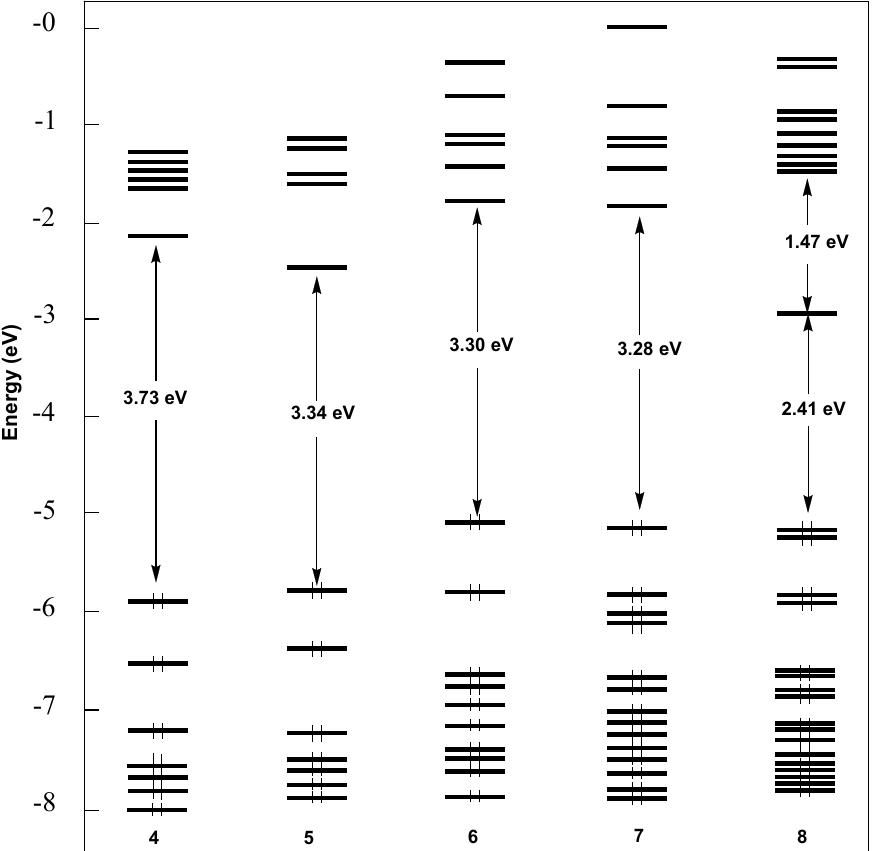
Figure 5. The MO energy level ordering of the five investigated complexes.